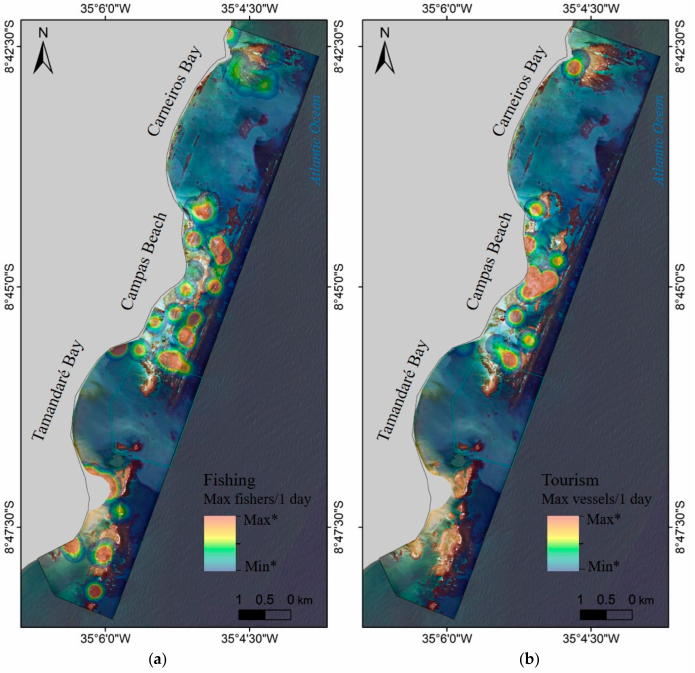
Figure 12. Use maps of the study area, including the main regions: Tamandar é Bay, Campas Beach and Carneiros Bay. ( a ) Fishing pressure, calculated using the maximum number of fishers in the vicinities of a reef in a given day (max = 10 fishers); ( b ) tourism activities map, calculated using the maximum number of tourism-related vessels on a reef or its proximities in a given day (max = 18 vessels, 74